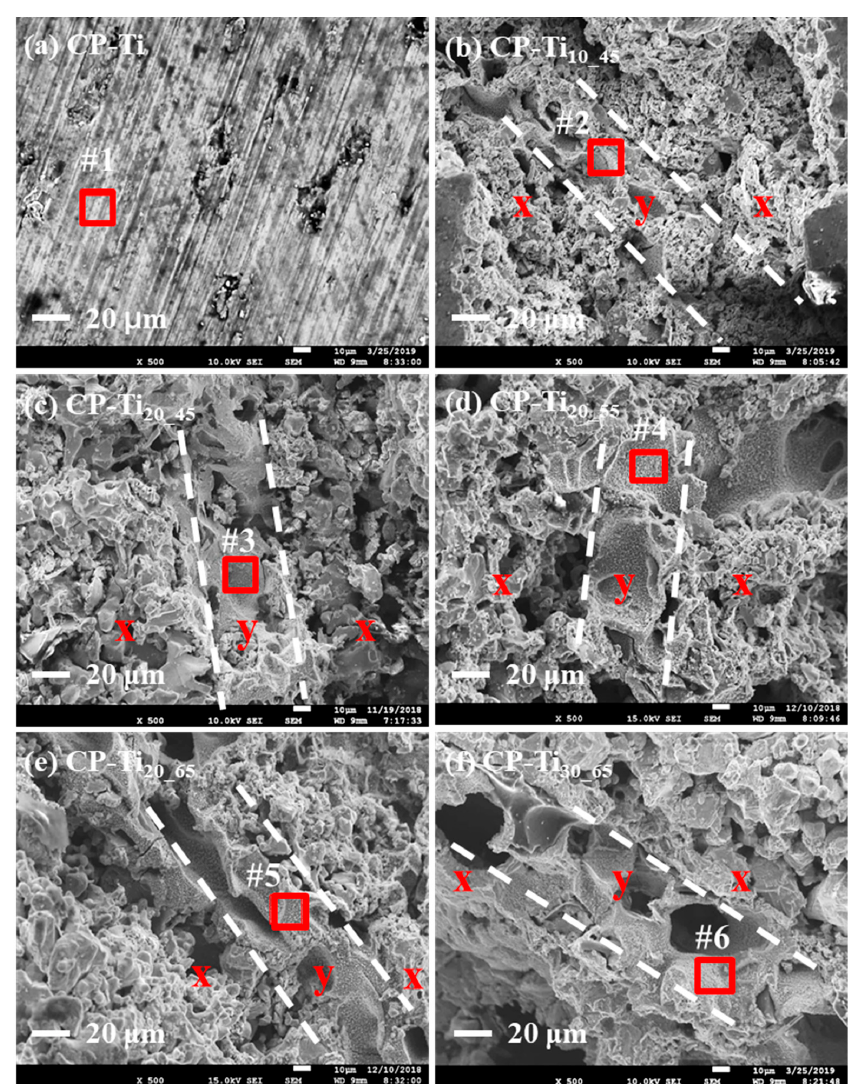
Figure 3. Scanning electron microscope (SEM) photo-images of dual porous structures: ( a ) CP-Ti, ( b ) CP-Ti 10_45 , ( c ) CP-Ti 20_45 , ( d ) CP-Ti 20_55 ( e ) CP-Ti 20_65 , and ( f ) CP-Ti 30_65 . The morphologies ( b )~( f ) indicate the boundaries (i.e., denoted as the two dotted lines) of the dual porous structures (denoted as x and y) from the surfaces of P-Ti x_y . The corresponding EDS spectra within the region y, respectively marked with red squares (#1~6), were shown in Figure S1.